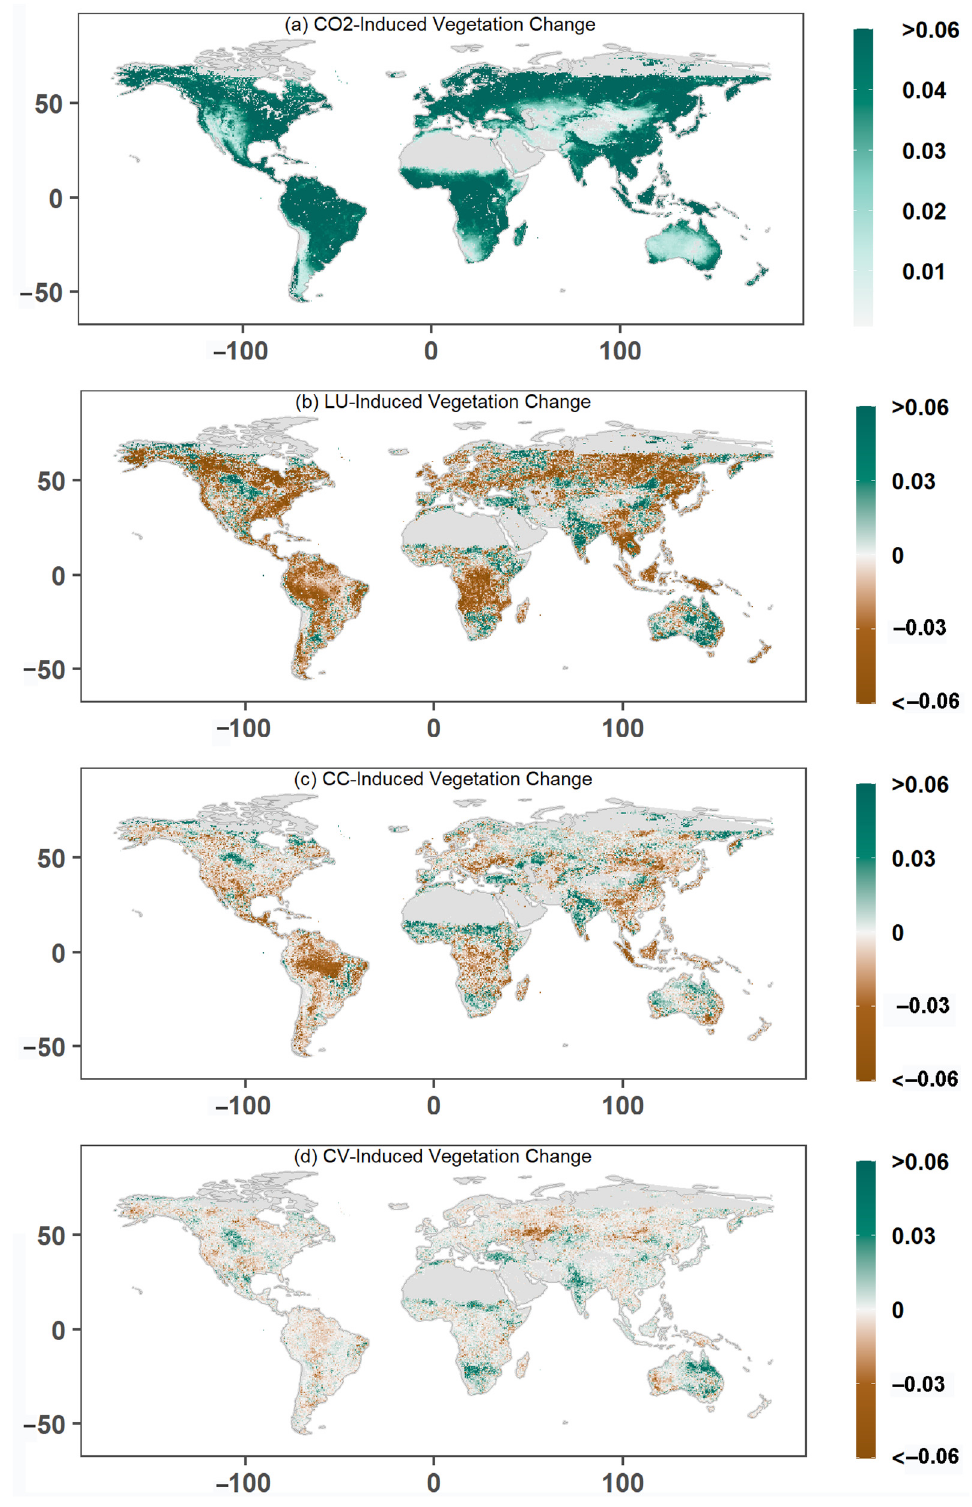
Figure 4. Driving factors of global vegetation change. The NDVI changes during 1982–2015 were attributed to ( a ) CO 2 fertilization (CO 2 ), ( b ) land use (LU), ( c ) climate change (CC), and ( d ) climate variability (CV). CO 2 positively impacts vegetation change (Figures 4a and 5a), resulting in a 0.035 increase in global NDVI since the 1980s (Figure S6). Furthermore, CO 2 has the largest ab- solute contribution to global vegetation greenness change in 61.4% of vegetated lands,